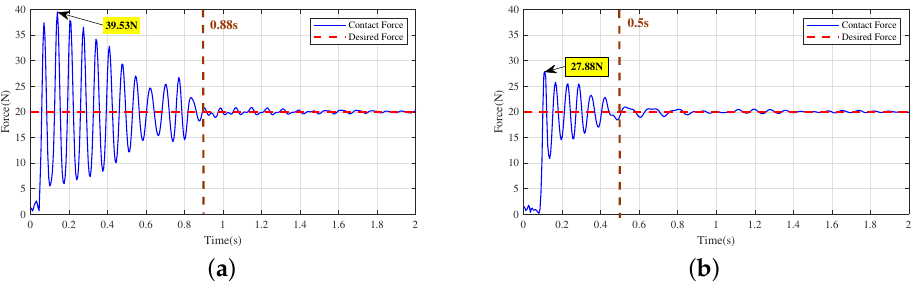
Figure 13. Contact force response when the tool of end-effector is 5 mm away from the workpiece surface (polishing spindle does not rotate): ( a ) Direct force control without impedance matching. ( b ) Direct force control with impedance matching.